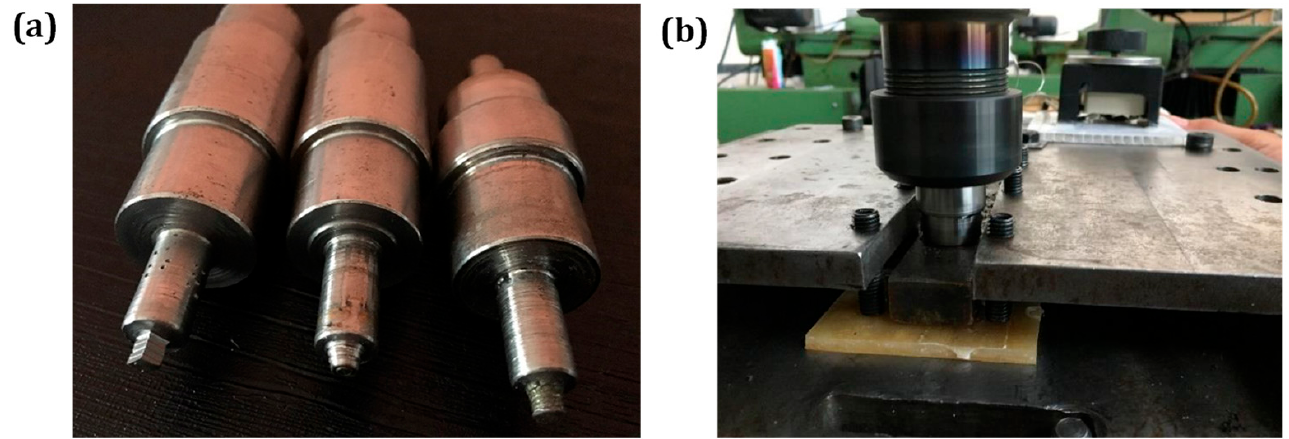
Figure 1. Photographs of ( a ) selected pin profiles ( b ) FSW process. Table 1. Input parameters and values of each factor.